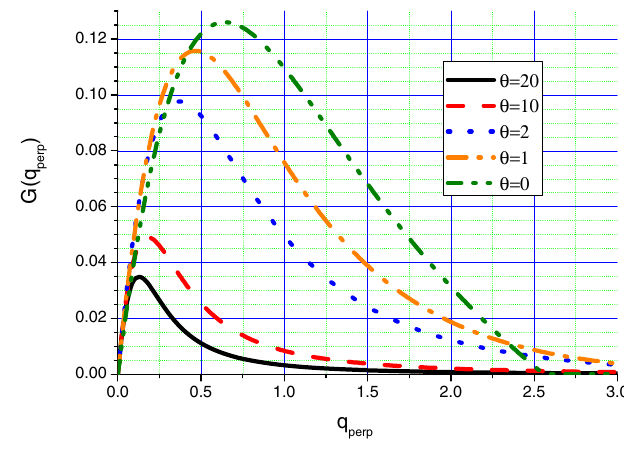
(cid:1) (cid:2) q versus q perp , in atomic units, at various perp